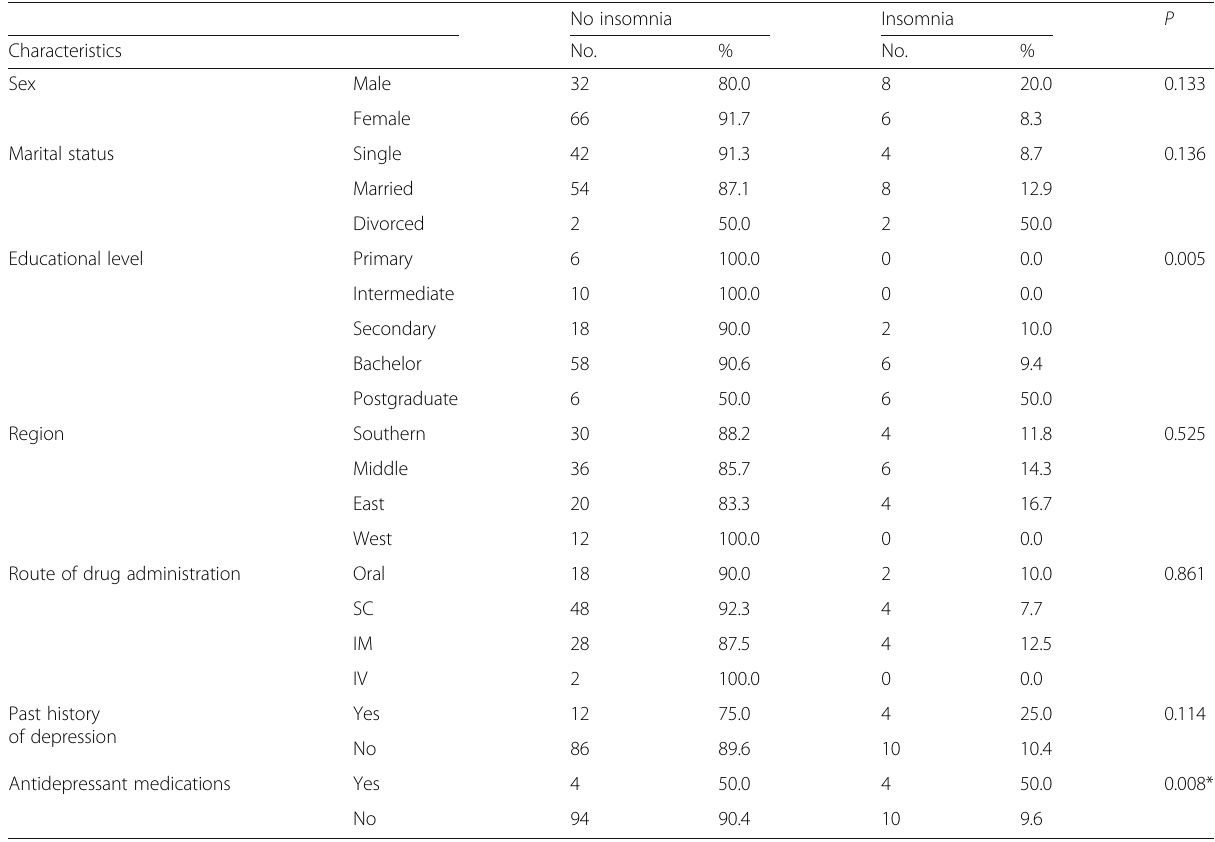
Table 3 Associations regarding socio-demographic variables between insomnia and no insomnia groups in non-depressed MS patients